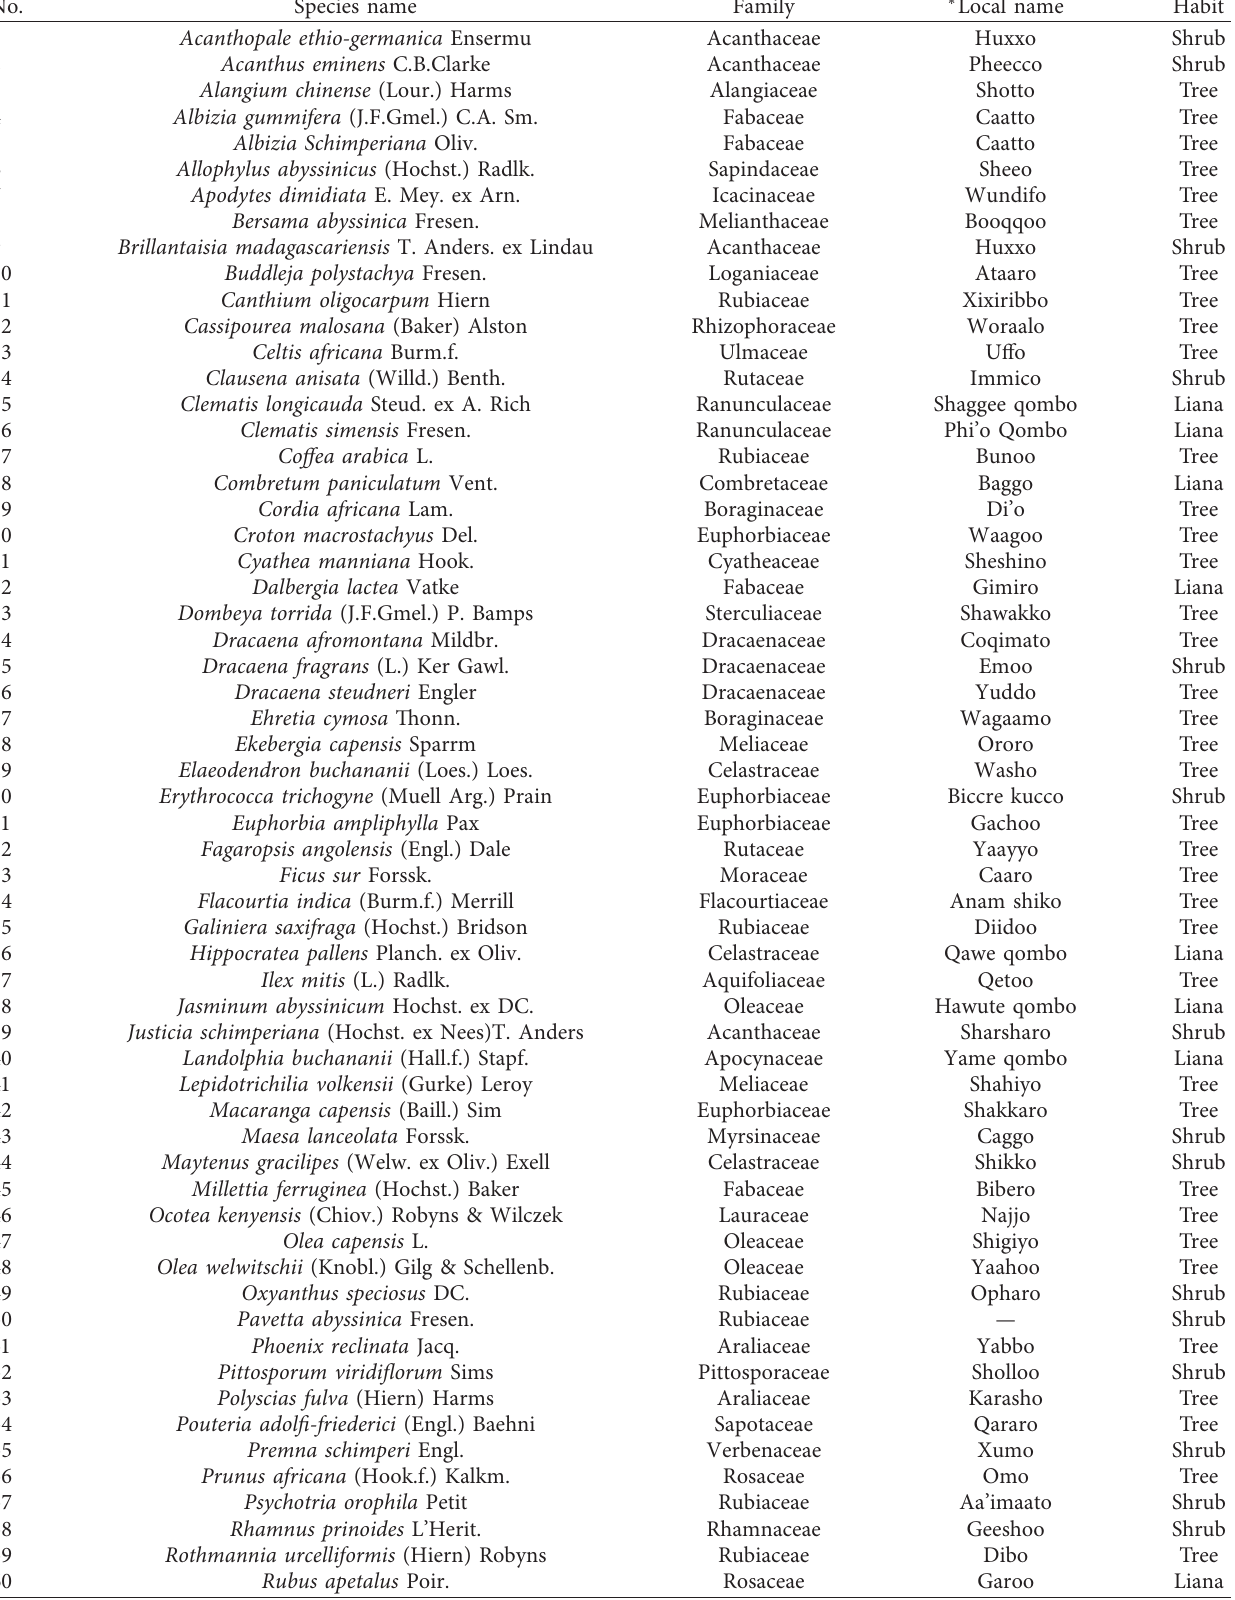
Table 1: List of woody species in Agama moist Afromontane